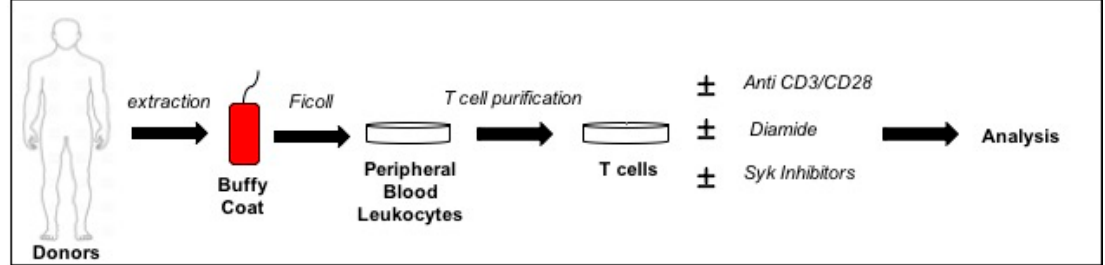
Figure 1. General experimental plan of the study. Buffy coat with peripheral blood leukocytes were extracted from healthy donors. T cells were obtained by Ficoll/Histopaque centrifugation and subsequent column purification. They were left 24 h before to be treated with activators/diamide/syk inhibitors.